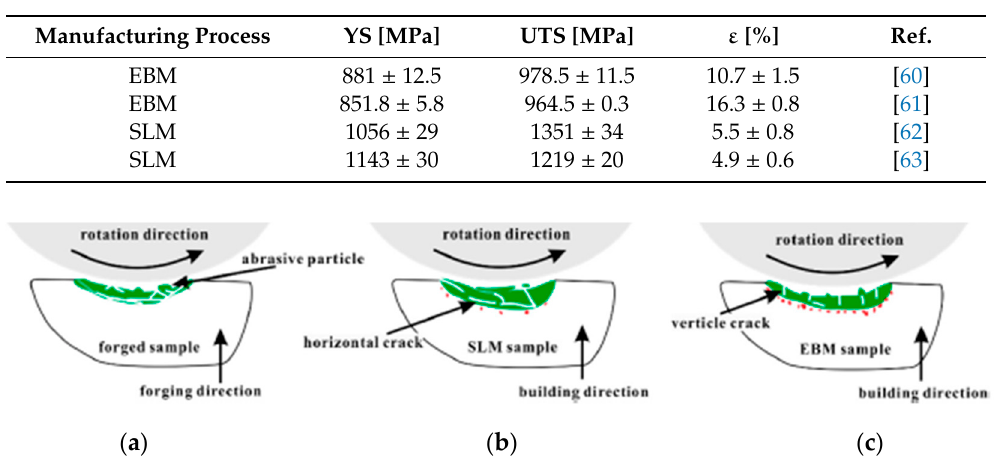
Table 1. Mechanical properties of as-built Ti–6Al–4V specimens in tensile testing. UTS: ultimate tensile strength, YS: yield strength.